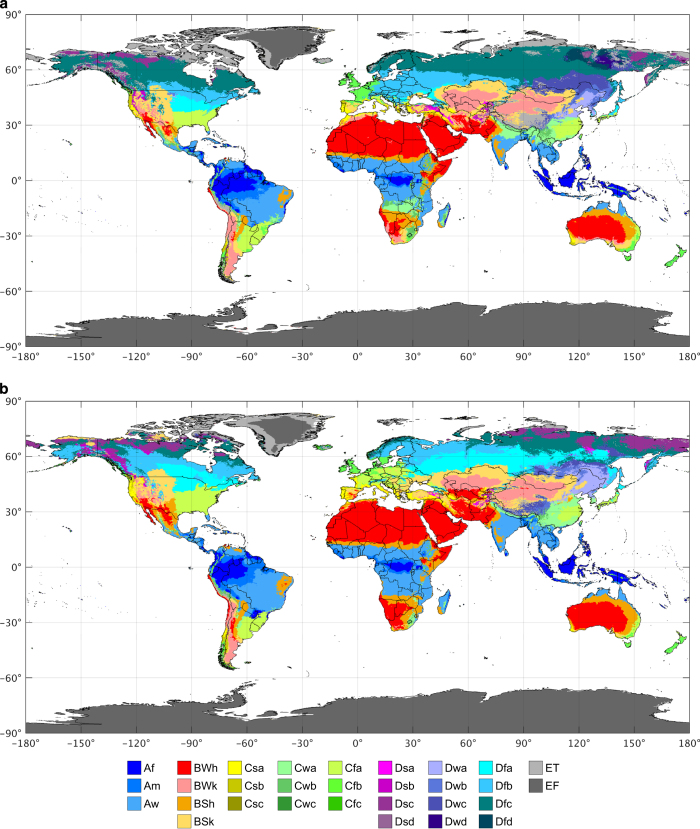
New and improved Köppen-Geiger classifications.Part (a) shows the present-day map (1980–2016) and panel (b) the future map (2071–2100). The color scheme was adopted from Peel et al.21.